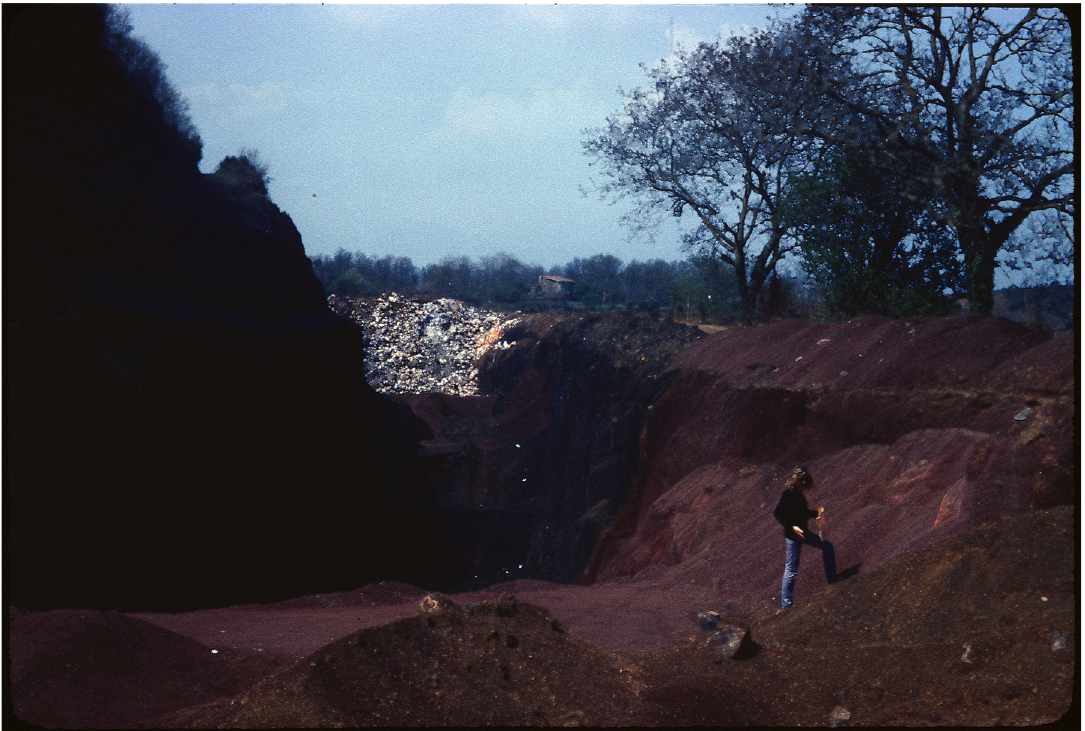
Figure 5: Dump at the Croscat volcano, around 1980. Source: Lluís Pallí Buxó. Universitat de Girona. Biblioteca. Fons Lluís Pallí: register